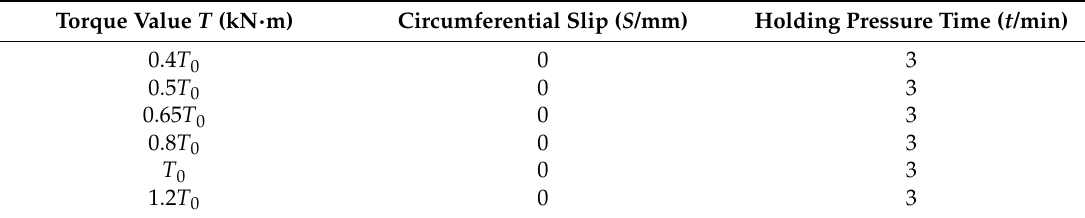
Figure 4. Test bench of turbine shrink disk. Table 3. Static torque detection data.